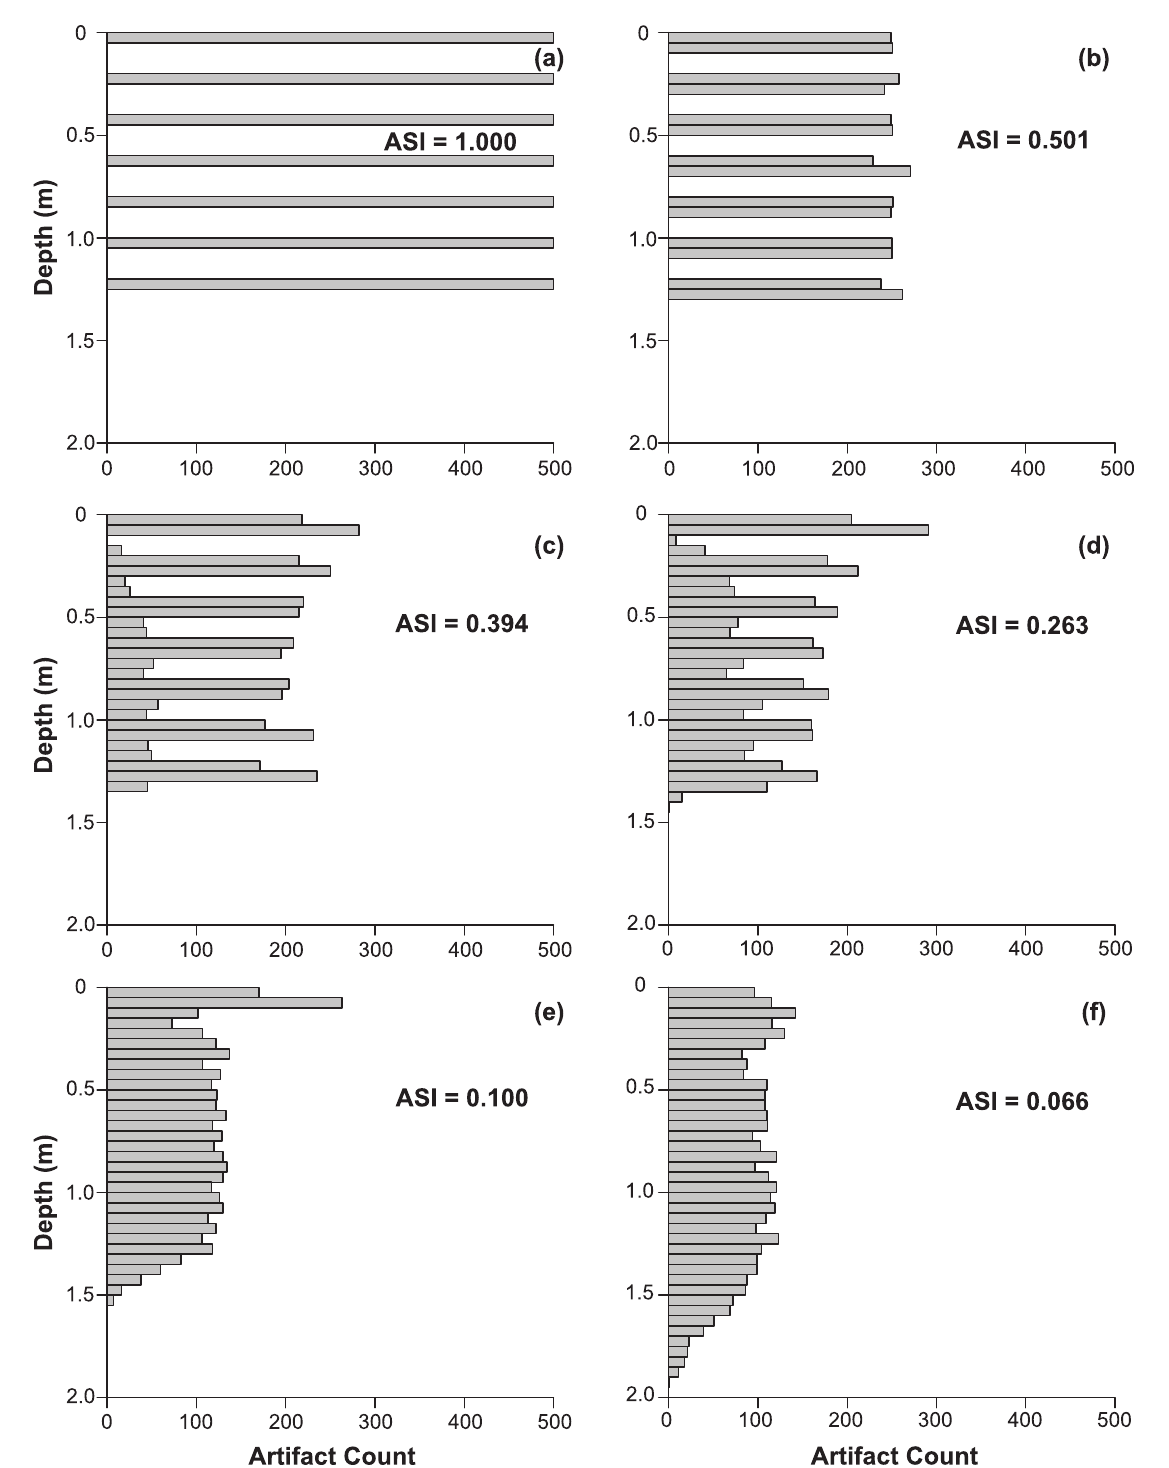
Fig 3. ASI values for six simulated artifact distributions from no mixing (a) to severe mixing (f).